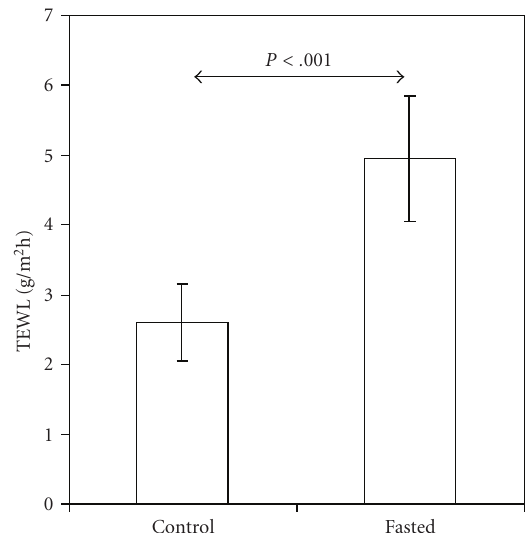
Figure 6: Transepidermal water loss (TEWL) is higher in 1-day- old term rat pups at the end of an 18-h period of fasting (fasted; n = 18) than in suckling controls ( n = 19). Values are presented as mean ± SD.